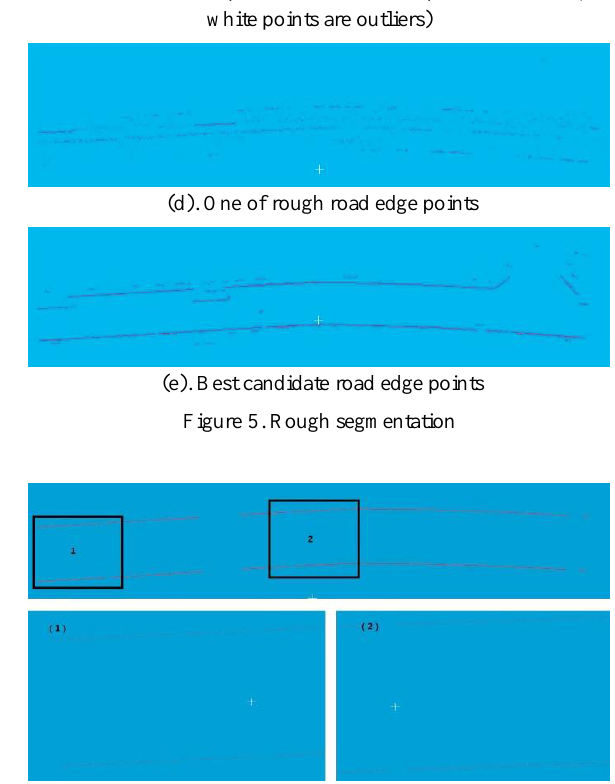
Figure 6. Refining based on road width and